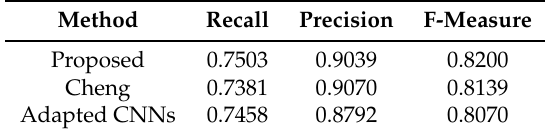
Table 4. Performance comparison on specific piano transcription.